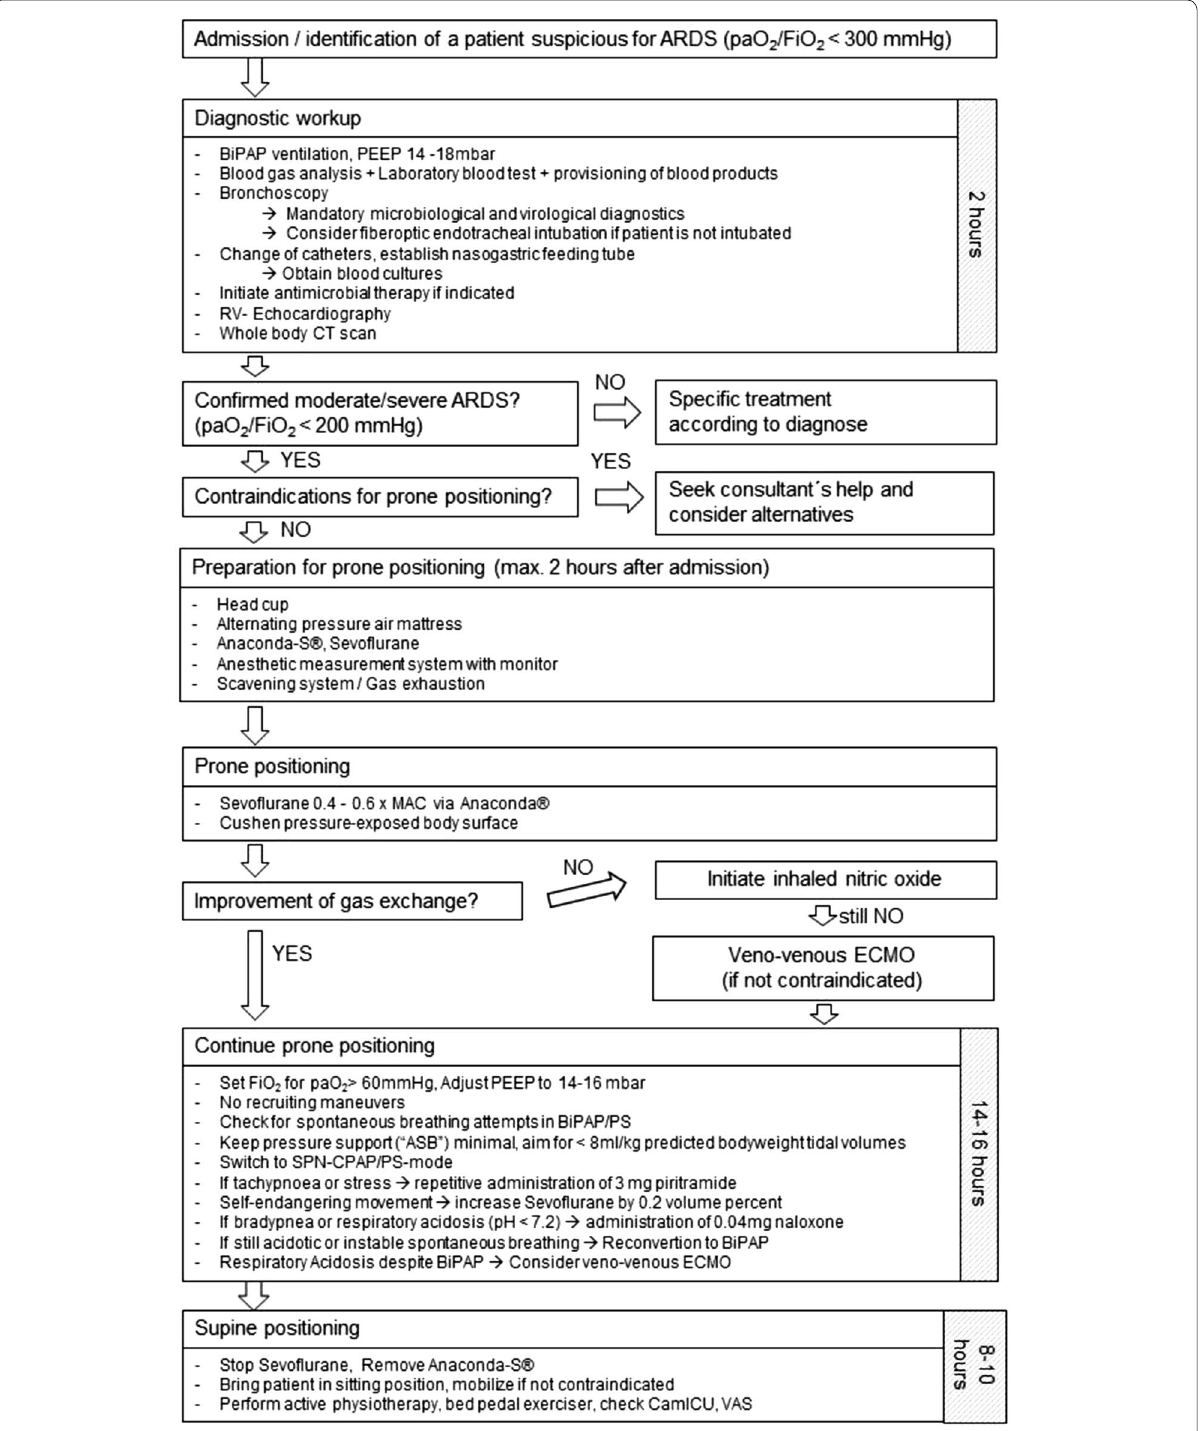
Fig. 1 Departmental standard operating procedure for workup in